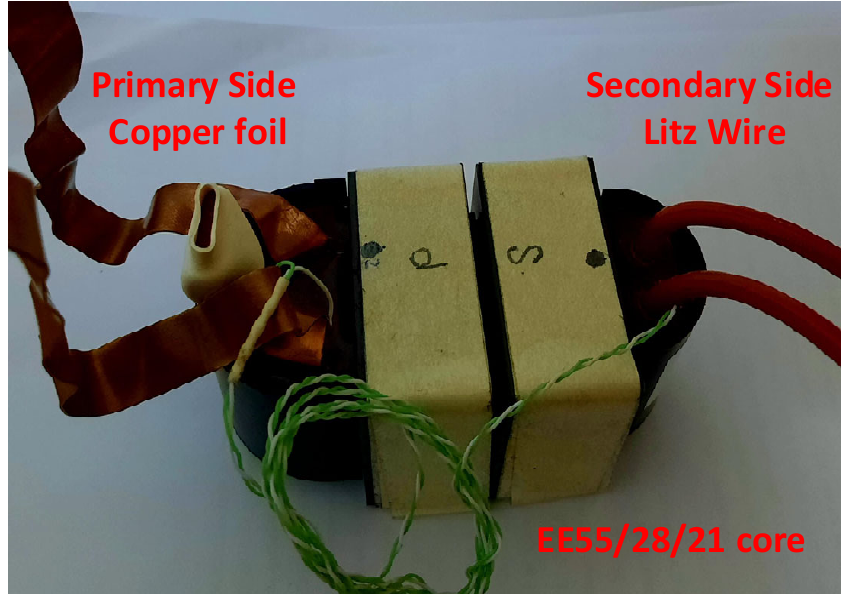
Figure 8. The 5 kW ferrite core (N87) high ‐ frequency transformer prototype.